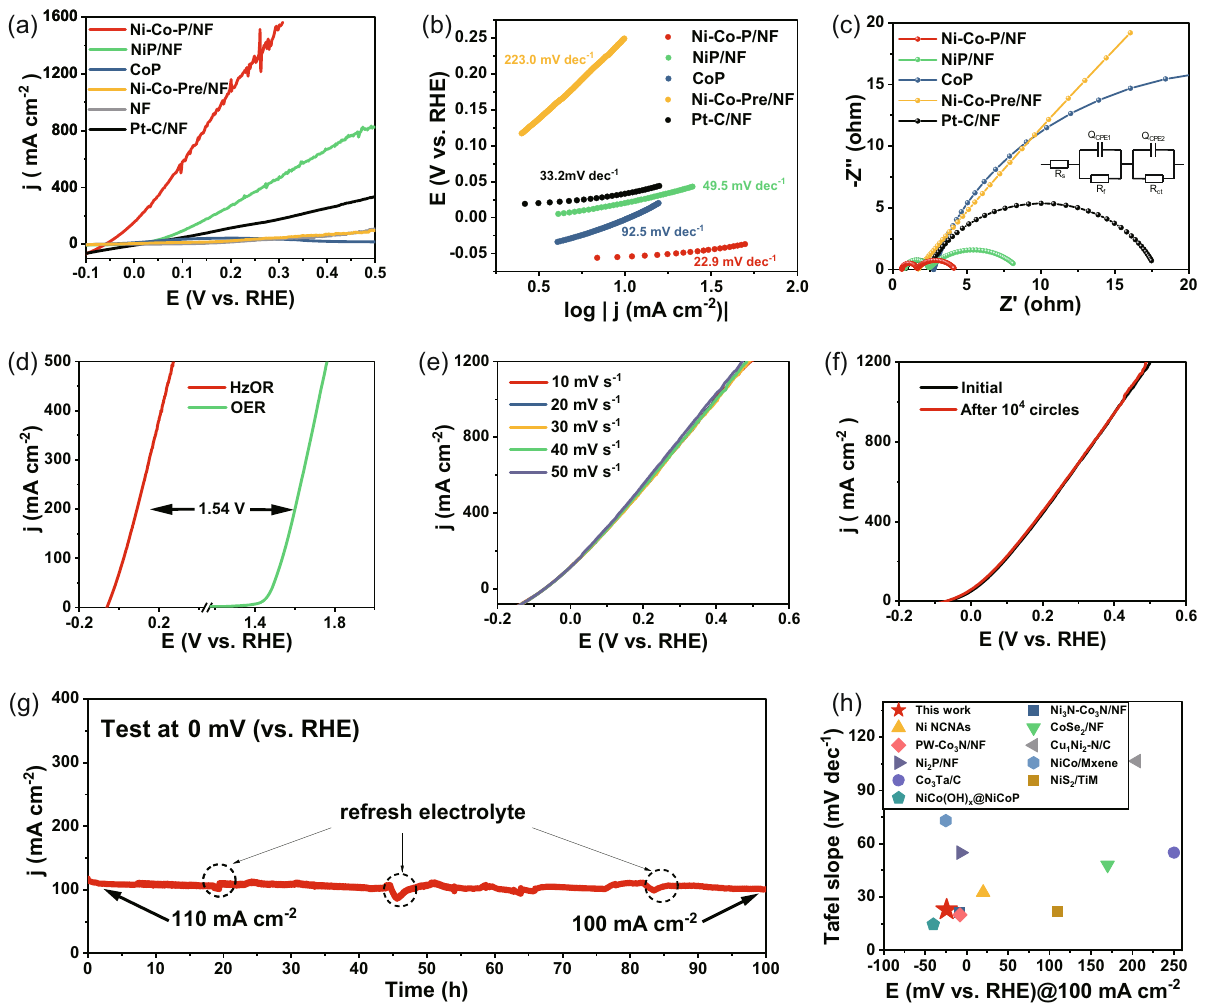
Fig. 4 | Electrochemical properties of the HzOR in 1.0M KOH and 0.1M N 2 H 4 . a 50% iR-corrected LSV (The compensation resistance is about 0.31 Ω with the corresponding non-iR compensated data shown in Fig. S16a); b Tafel slope plots; c Nyquist plots with the fi tting pattern in the inset; d Polarization comparison betweenHzOR of Ni-Co-P/NFand OER ofRuO 2 ; e LSV curvesof Ni-Co-P/NFvarying